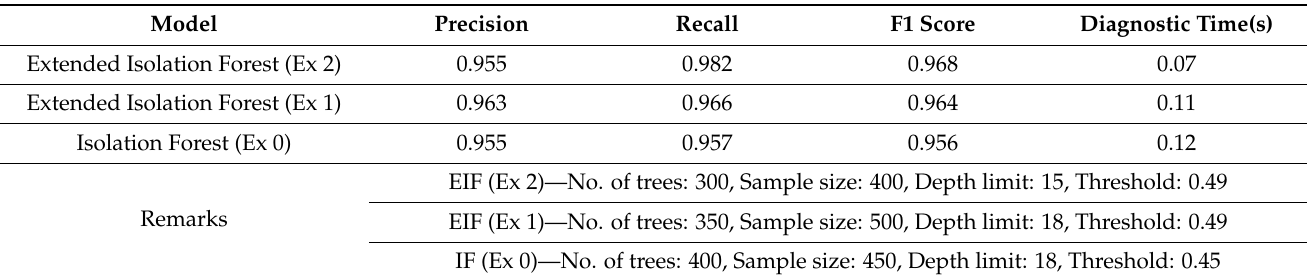
Table 4. Fault detection result of each